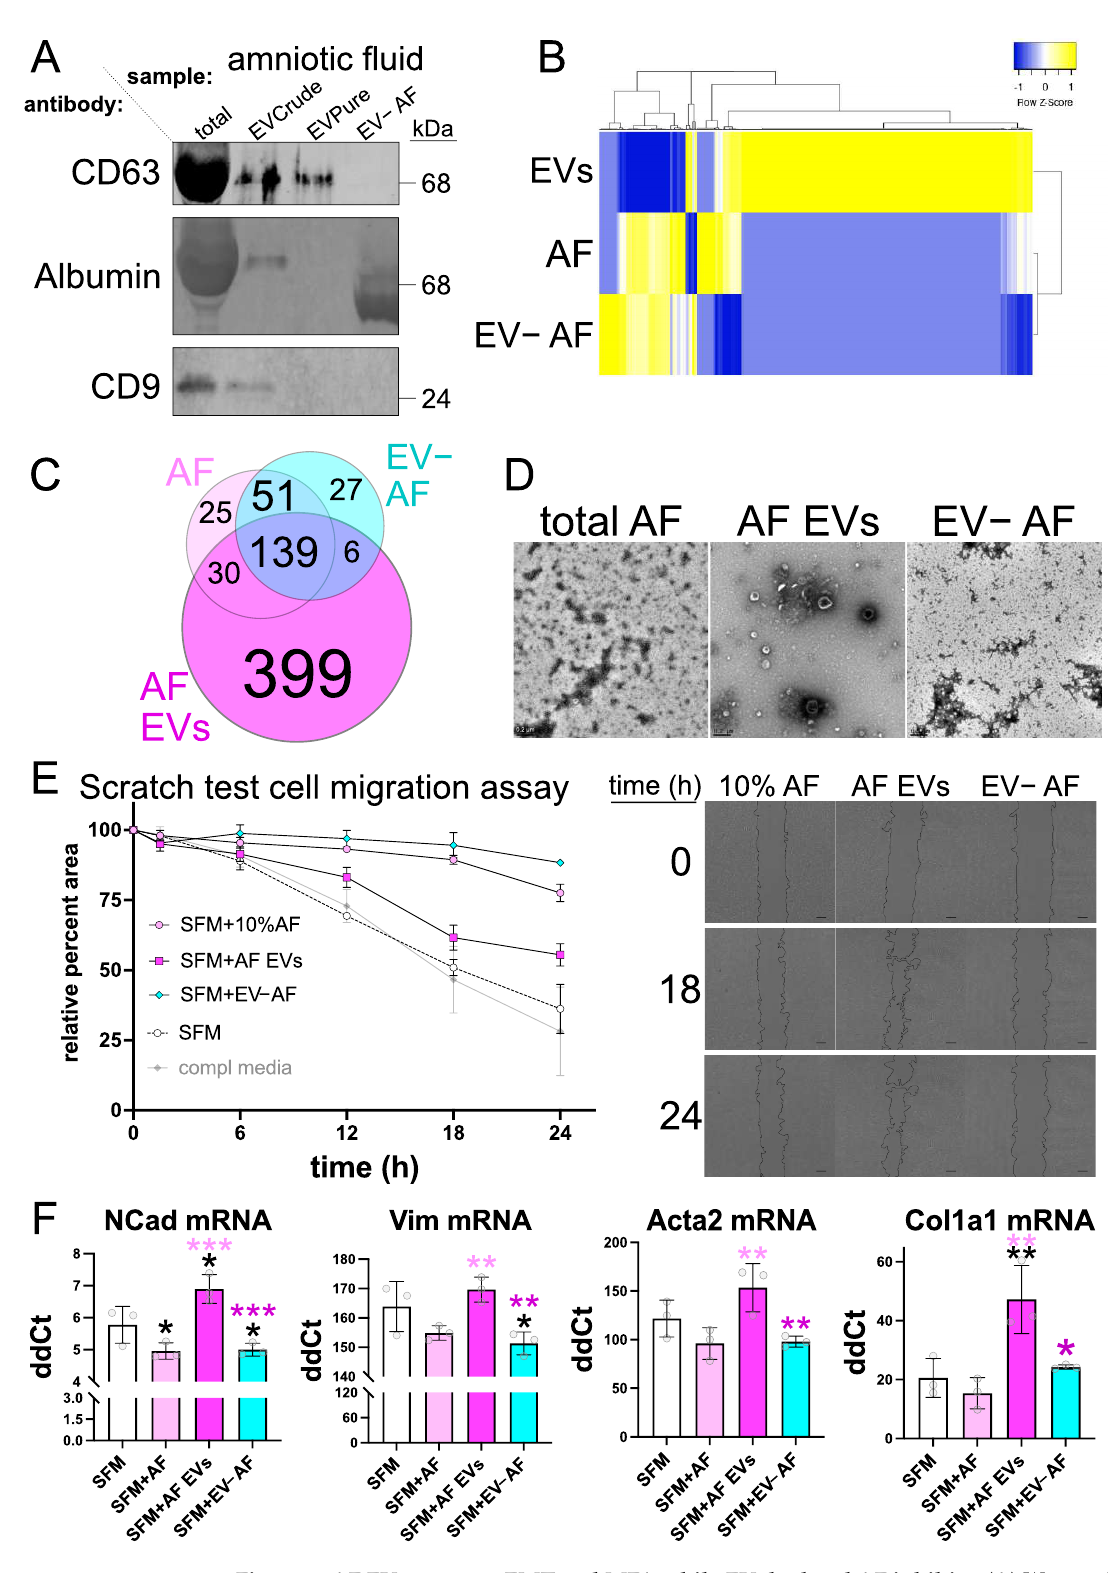
Figure 6. AF EVs promote EMT and MFA while EV-depleted AF inhibits. ( A ) Western blot of 1 µ g total AF, 1 µ g of crude extract from EV enrichment, an equal volume of purified EVs, and 1 µ g of EV- depleted AF probed with anti-CD63, anti-Albumin or anti-CD9 antibodies (see also Supplementary Figure S4 for uncropped Western blots and sequential probing scheme; we note that the signal shown for CD63 in total AF is likely an artifact from highly abundant Albumin protein). ( B ) Proteomic profile of biological replicate 2 (which had the deepest proteomics coverage) showing